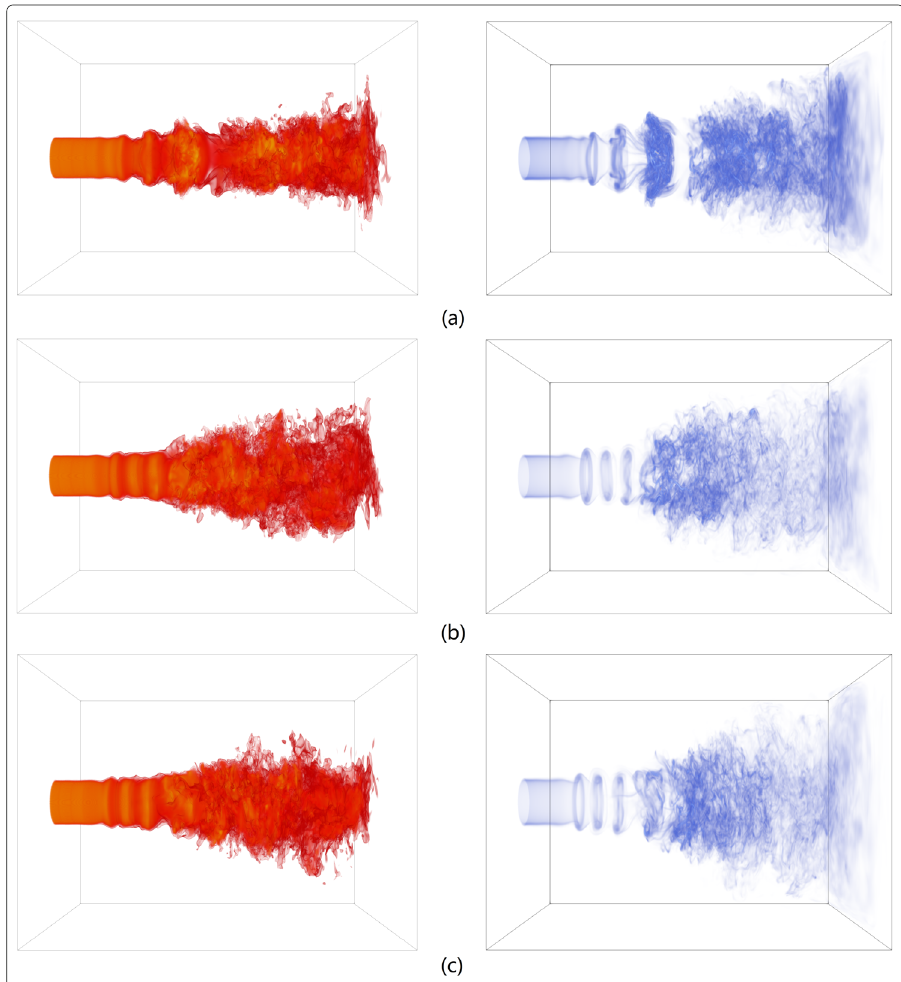
Fig. 6 Distribution of the data velocity field and the corresponding enstrophy in different time steps. a the start time step of the combustion simlulation. b the middle time step. c the end time